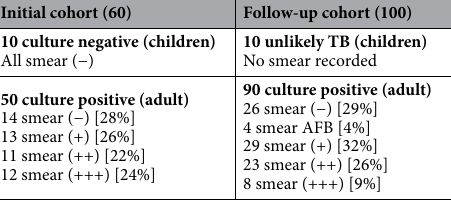
Table 1. Clinical Categorization of 160 urine sample set. Only 10/60 in the initial cohort and 2/100 in the follow-up cohort were HIV infected. Children are presumed HIV